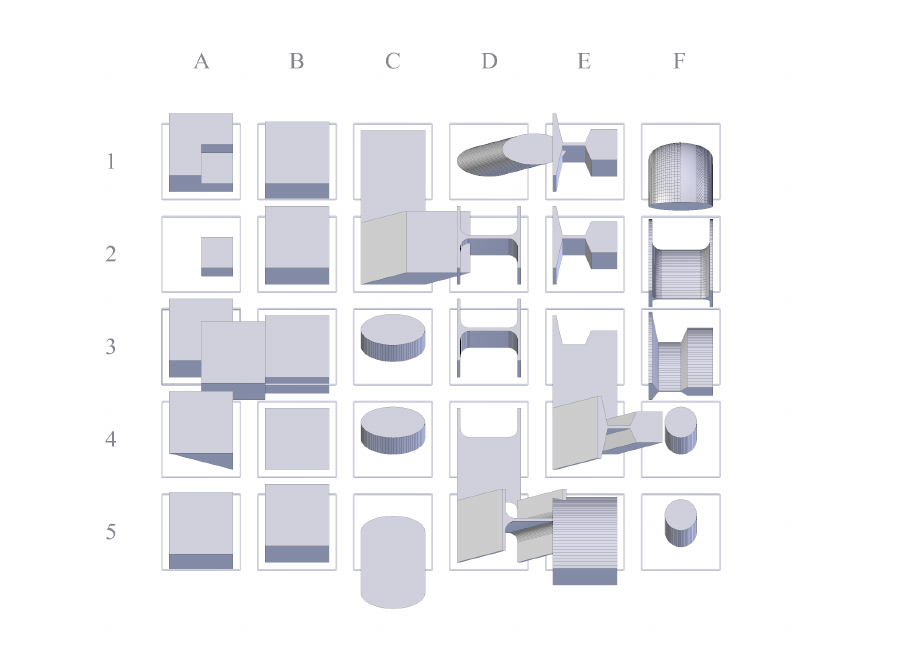
Figure 1. Reference schema of the modeled IFC